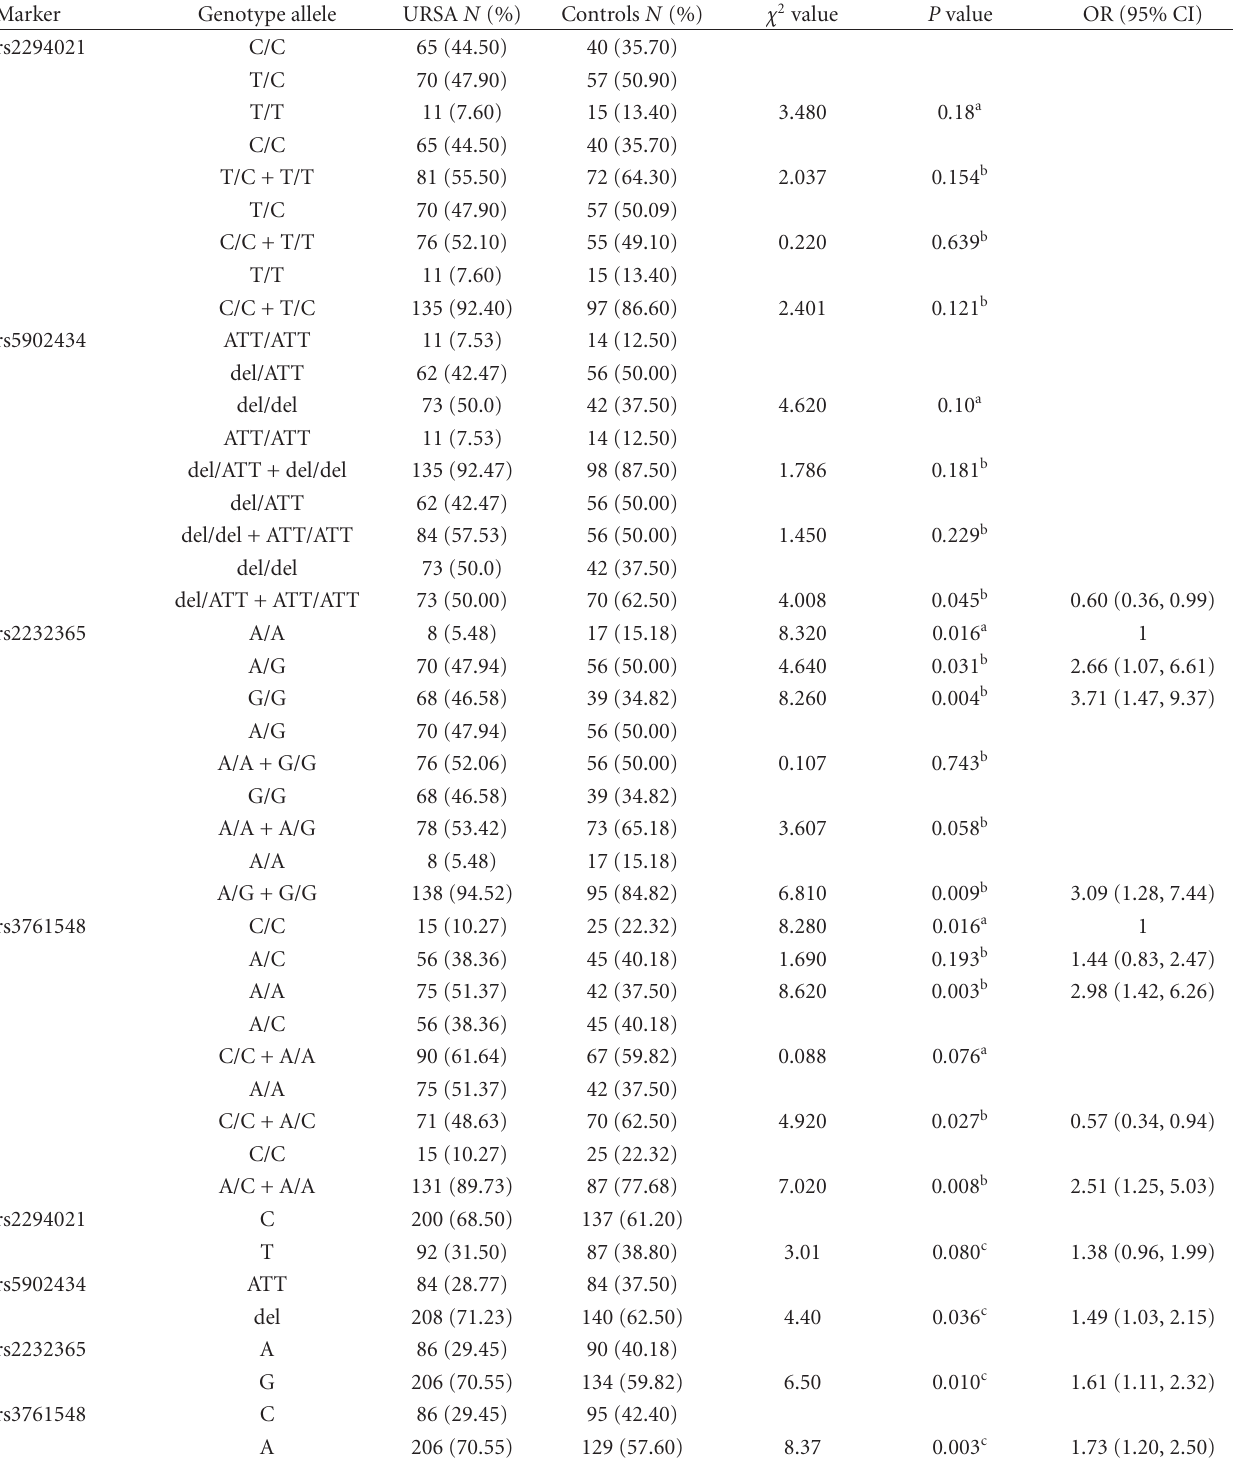
Table 2: Genotype and allele frequencies of the four Foxp3 polymorphisms in controls and URSA patients together with case-control